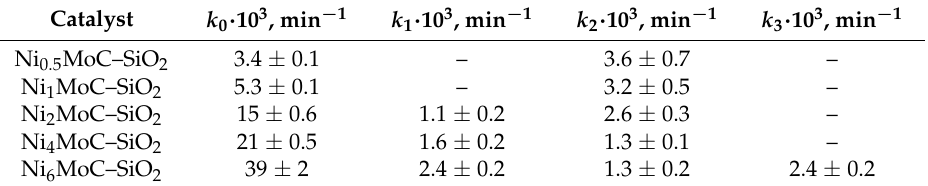
Table 8. Reaction rate constants of the furfural conversion over calcined and reduced Ni x MoC–SiO 2 equal to